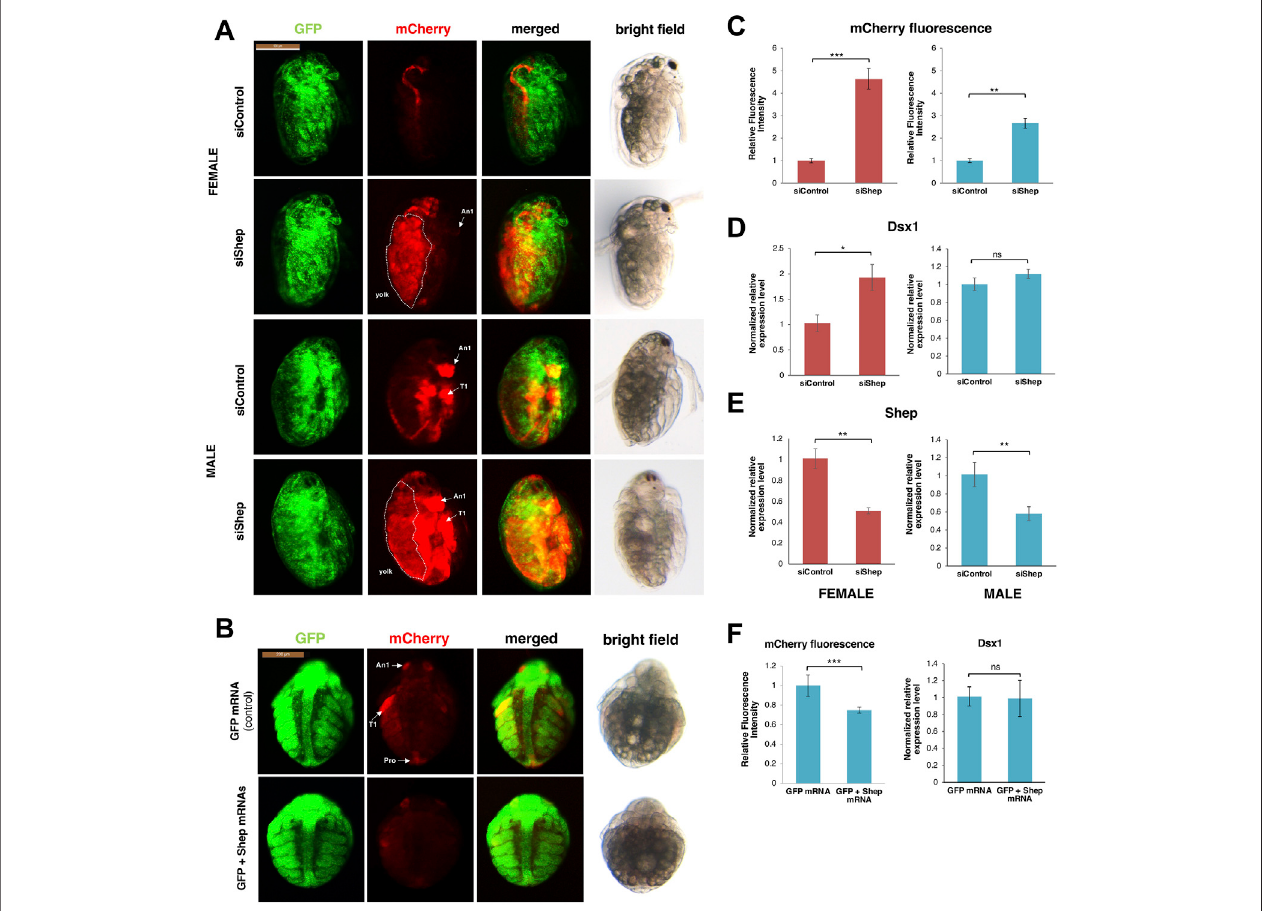
FIGURE 11 | Shep loss of function analysis. (A) Lateral view of female and male embryos of Dsx1 reporter strain injected with control siRNA and Shep siRNA and observed at 48 h after injection. mCherry fl uorescence allowed visualization of Dsx1 expression while GFP fl uorescence in the nucleus enabled observation of body structures. The merged images of mCherry and GFP and the bright fi eld images were used to understand the localization pattern of mCherry expression. An1: fi rst antennae, T1: fi rst thoracic leg, dotted lines: yolk area. (B) Ventral view of male embryos of Dsx1 reporter strain injected with GFP mRNA as control and GFP plus Shep mRNA observed at 30 h after injection. mCherry fl uorescence allowed visualization of Dsx1 expression while GFP fl uorescence in the nucleus enabled observation of body structures. The merged images of mCherry and GFP and the bright fi eld images were used to understand the localization pattern of mCherry expression. An1: fi rst antennae, T1: fi rst thoracic legs, Ge: genital. (C) Relative mCherry fl uorescence intensity calculated between Shep siRNA-and controlsiRNA-injected female(red) and male(blue) embryos. Error bars indicatethestandard error ofthemean ( n = 5). (D) Gene expression pro fi le of Dsx1 in control siRNA- and Shep siRNA-injected female (red) and male (blue) embryos. (E) Gene expression pro fi le of Shep in control siRNA- and Shep siRNA-injected female (red) and male (blue) embryos. (F) Relative mCherry fl uorescence intensity calculated between GFP mRNA- and GFP plus Shep mRNA-injected male embryos (left fi gure). Error bars indicate the standard error of the mean ( n = 5). Gene expression pro fi le of Dsx1 in GFP mRNA- and GFP plus Shep mRNA-injected male embryos (right fi gure). RT-qPCR results are shown as expression levels normalized with housekeeping genes L32 , L8 , and Cyclophilin and relatively compared to the control. Error bars indicate the standard error of the mean ( n = 3). * p < 0.05, ** p < 0.01, *** p < 0.001, ns: not signi fi cant (Student ’ s t -test). Adapted from Perez et al. (2021).